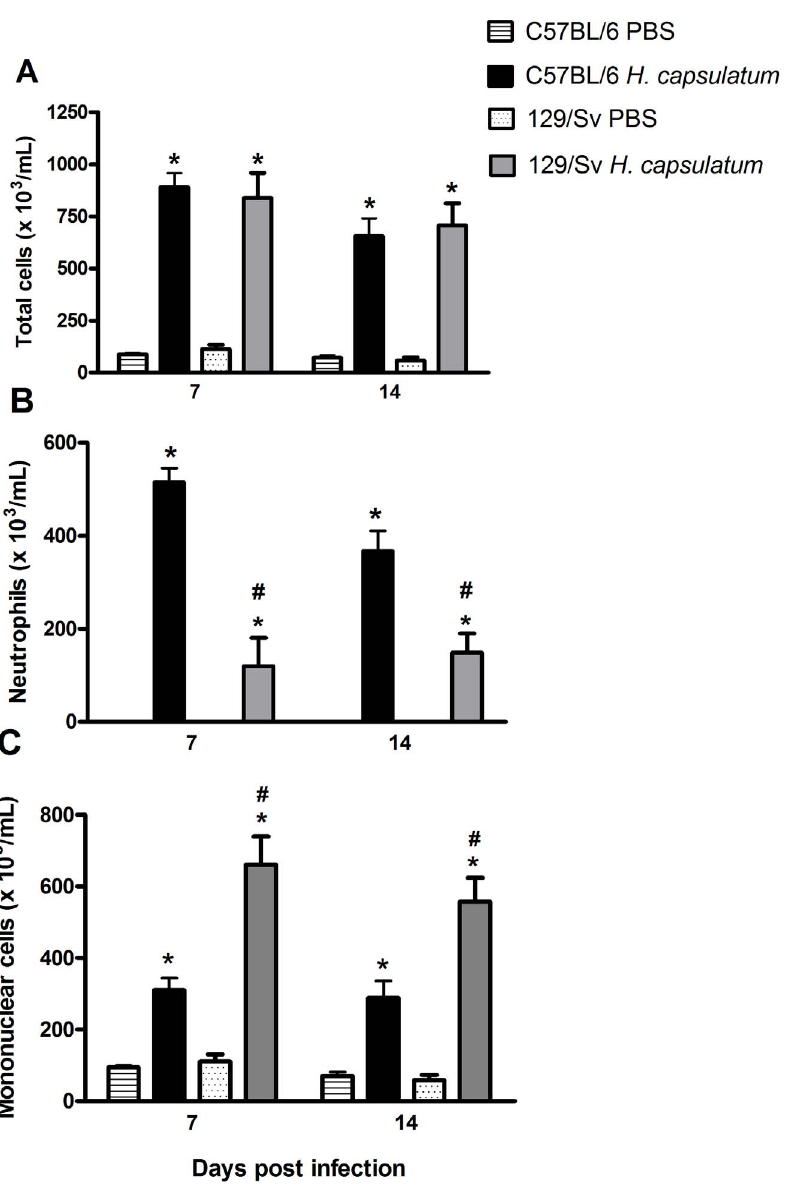
Figure 2. Differential leukocyte recruitment to the lung in resistant (129/Sv) and susceptible (C57BL/6) mice. Cells were obtained from mice at 7 and 14 days after i.t. injection of PBS or 5 6 10 5 H. capsulatum yeast cells, as described in the Materials and Methods section. The total cells (A), neutrophils (B) and mononuclear cells (C) were enumerated and identified after Rosenfeld staining. The data are expressed as the mean 6 SEM from one representative experiment of a total of three experiments (n=6/each experiment). *C57BL/6 and sv129 compared with PBS; # C57BL/6 compared with sv129. p , 0.05 was considered significant.